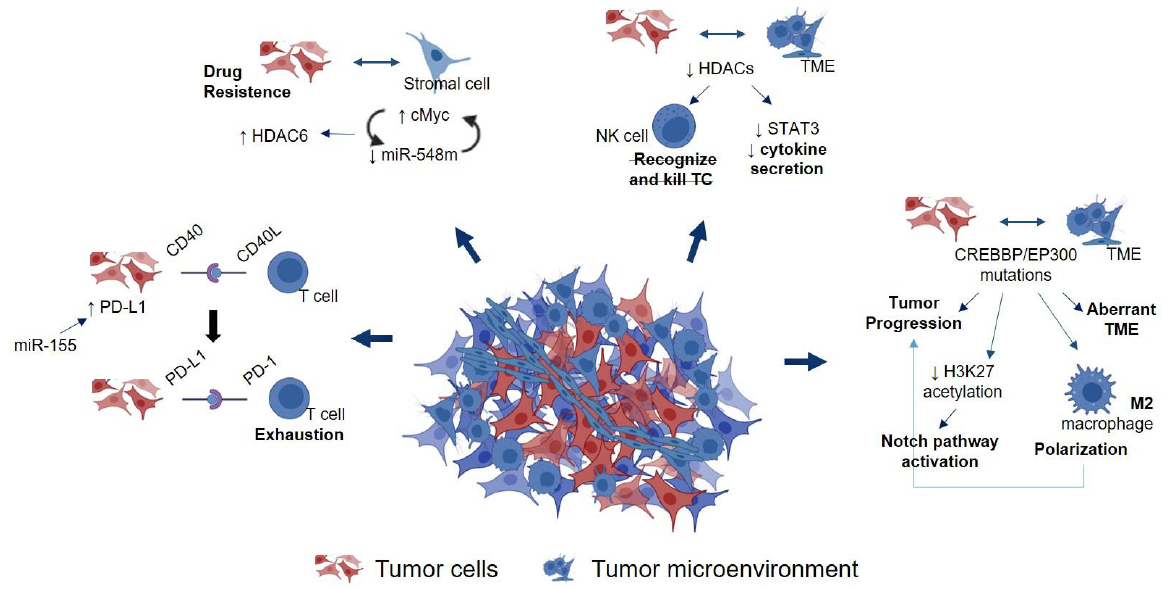
Figure 2. Schematic representation of the epigenetic cross-talk between lymphoma tumor cells (TC) and the tumor microenvironment (TME) in lymphoma diseases.